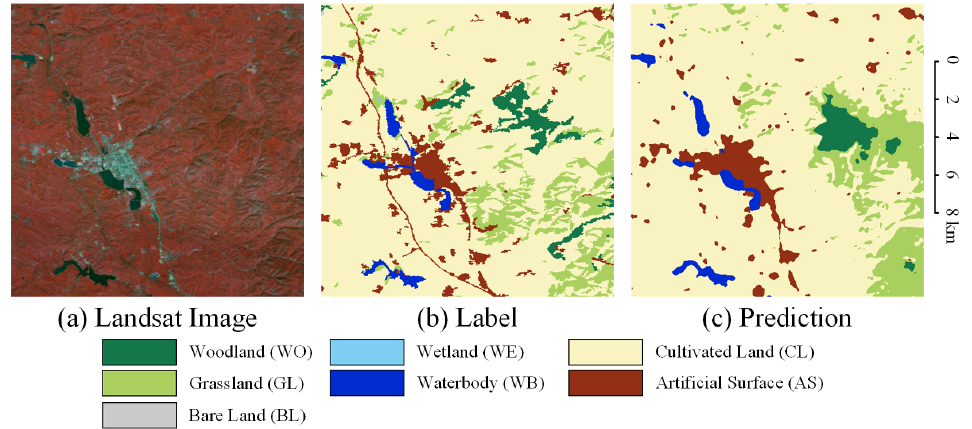
Figure 1. Effect of the pooling operation in DCNNs. ( a ) The pseudocolor Landsat image. ( b ) The semantic segmentation label. ( c ) The prediction result of the